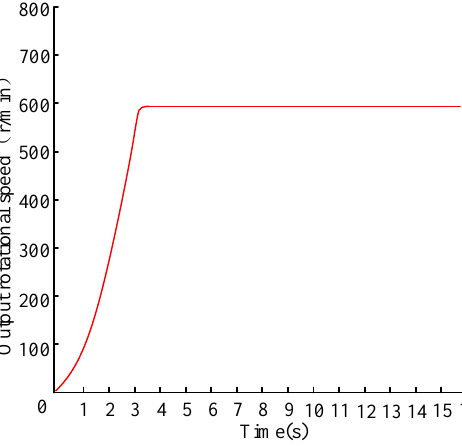
Figure 23. PMSC speed response for the adaptive NFTSM algorithm.